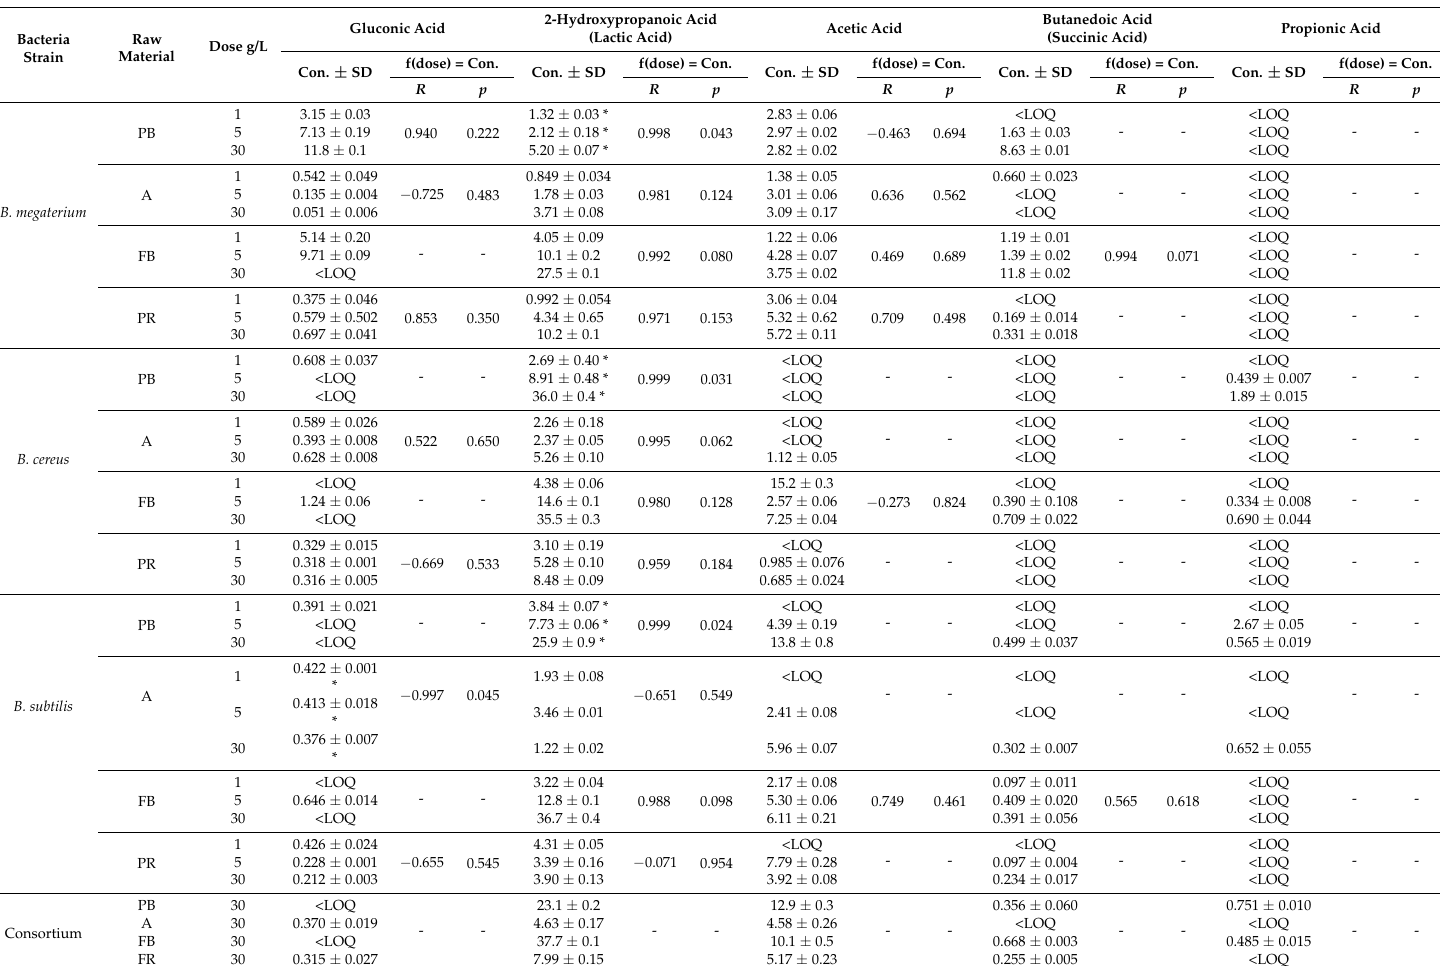
Table 3. The levels of detected organic acid concentrations (mmol/L) in the culture broth of Bacillus species under different conditions. GluconicAcid 2-HydroxypropanoicAcid (LacticAcid) AceticAcid ButanedoicAcid (SuccinicAcid) PropionicAcid Raw Bacteria Doseg/L Material Strain Con. ± SD f(dose)=Con. Con. ± SD f(dose)=Con. Con. ± SD f(dose)=Con. Con. ± SD f(dose)=Con. Con. ± SD